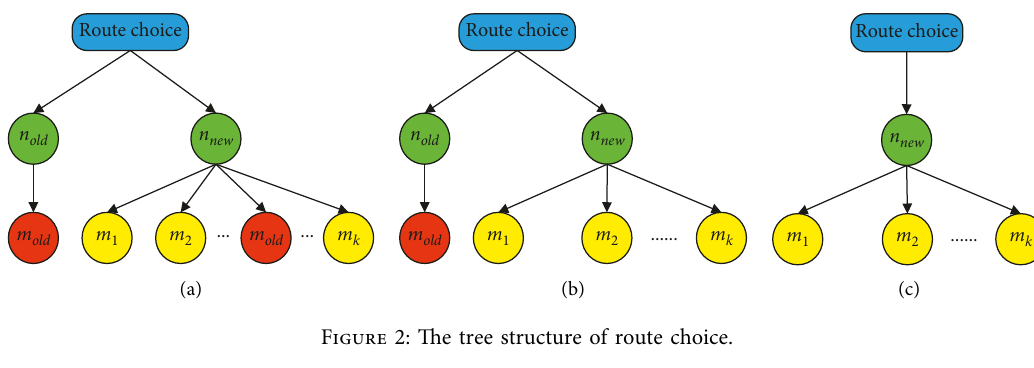
Figure 2: The tree structure of route